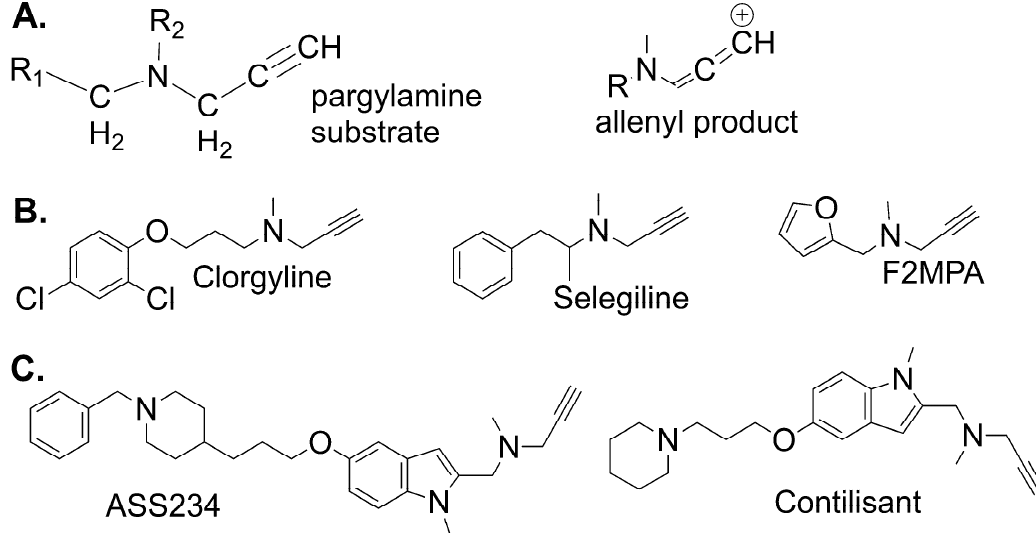
Figure 2. Propargylamine inactivators of MAO. ( A ) General structure of a propargylamine substrate for MAO-A and the allenyl product of oxidation. ( B ) Selective propargylamine inactivators: clorgyline is MAO-A-selective, selegiline and F2MPA are MAO-B-selective. ( C ) New propargylamine compounds incorporating cholinesterase inhibition: ASS234 is MAO-A-selective [18], Contilisant inhibits both MAO-A and MAO-B [36].